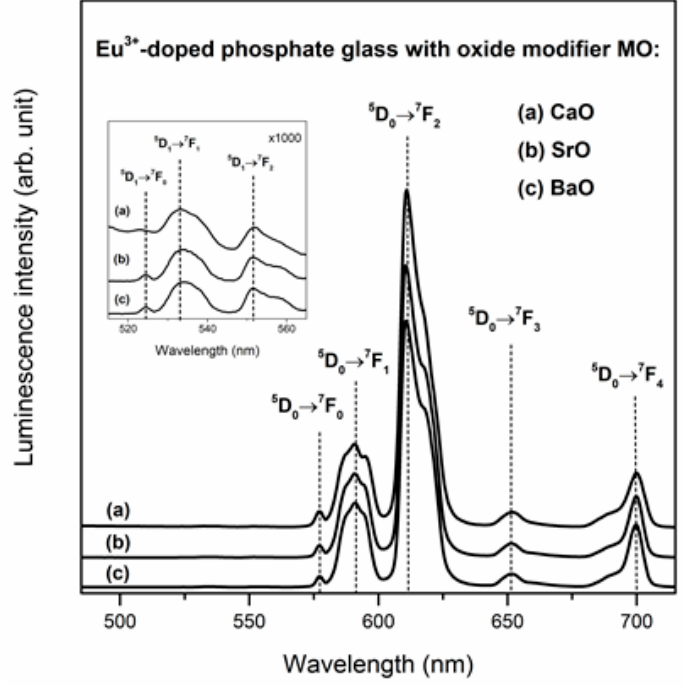
Figure 8. Luminescence spectra for Eu 3+ -doped phosphate glasses with oxide glass modifiers